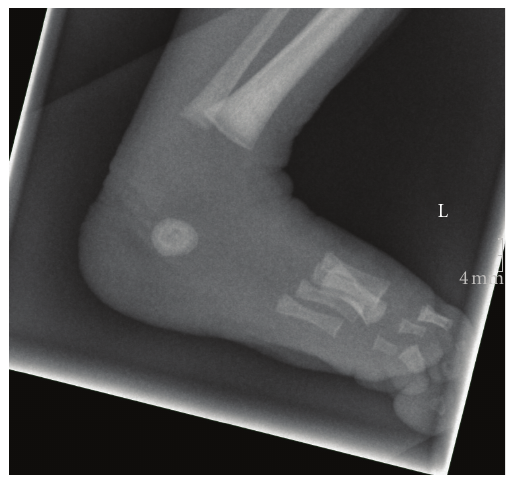
Figure 1: Radiograph of the baby’s foot at 20 days of chronological age. Bone age has been classified as 28th–30th gestational week; thus, bone age is significantly retarded (according to the Hernandez/ Erasmie score).